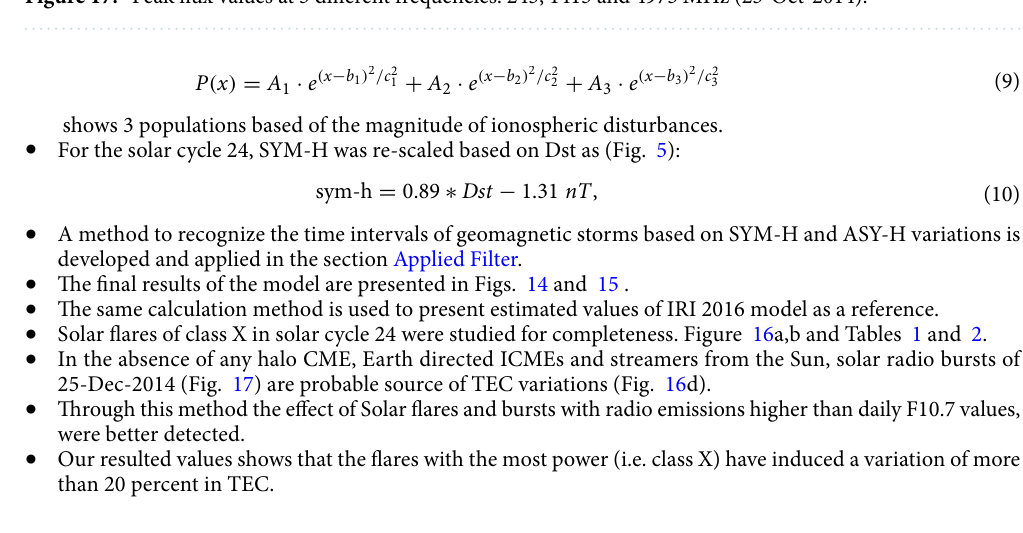
Figure 17. Peak flux values at 3 different frequencies: 245, 1415 and 4975 MHz